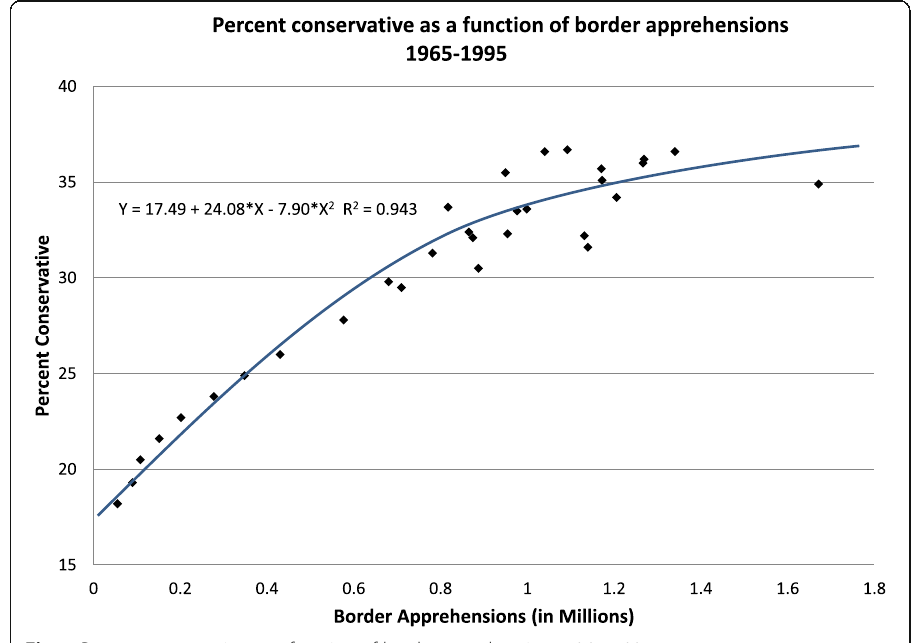
Fig. 4 Percent conservative as a function of border apprehensions 1965 –